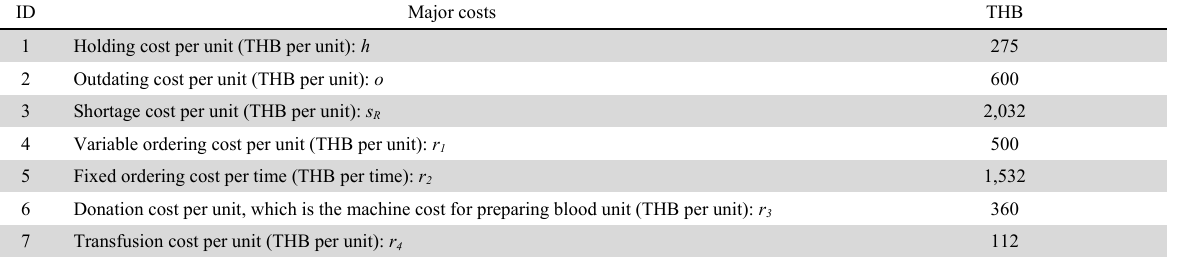
Major costs based on operation costs from medical laboratory at the SUT hospital